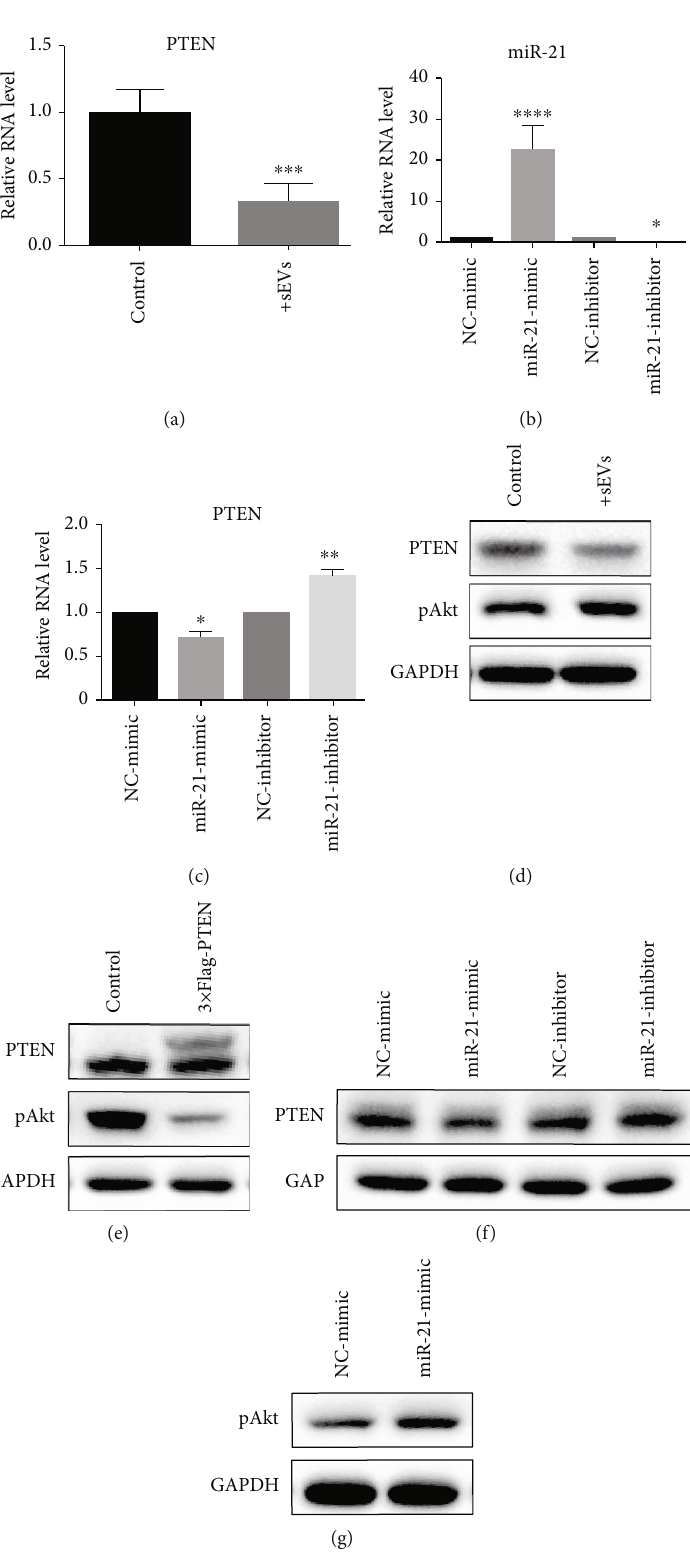
Figure 6: miR-21 regulates HCECs ’ proliferation and migration by activating PI3K/Akt pathway through targeting PTEN. (a, d) HUMSC- sEV treatment decreased the RNA and protein levels of PTEN in HCECs. (b) The expression level of miR-21 in HCECs. (c, f) The PTEN changed with miR-21 variation. (e) The expression of phospho-Akt after overexpression of PTEN. (g) The expression level of phospho-Akt after transfected with miR-21 mimics was detected by Western blot. Data are expressed as the means ± SD . ∗ P < 0 : 05 , ∗∗ P < 0 : 01 , and ∗∗∗ P < 0 : 001